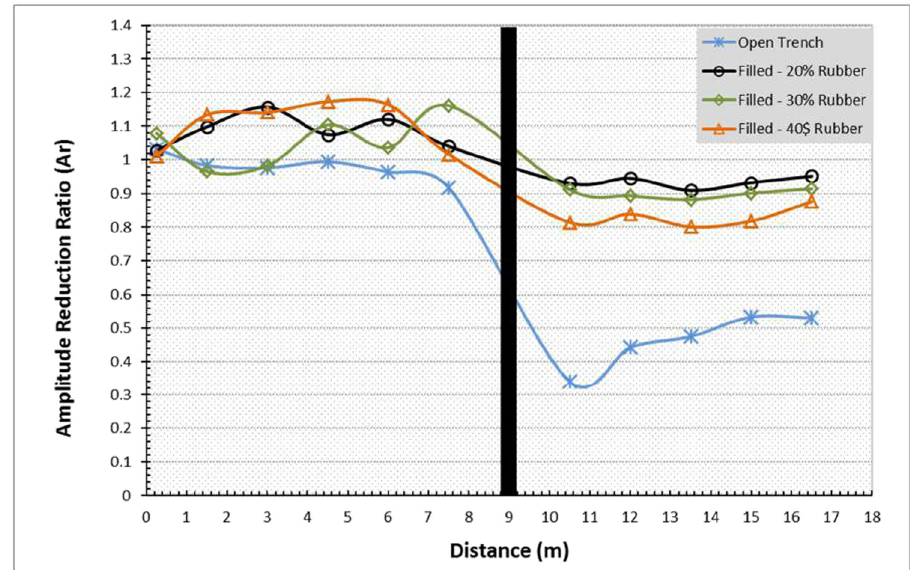
Figure 18: Attenuation of vibration due to passive trench barriers ( f 30 Hz = )